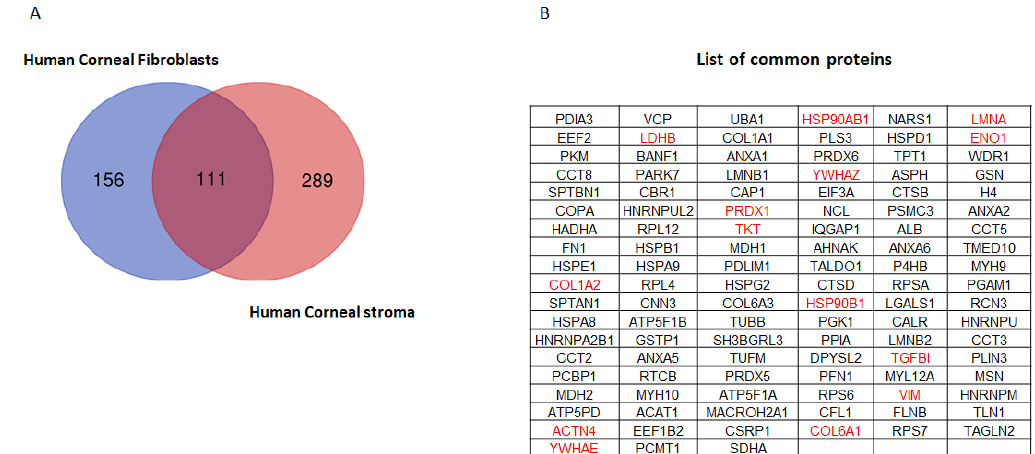
Figure 6. ( A ) Venn diagram of common and unique proteins compared between human corneal fibroblasts and human corneal stroma. A total of 111 proteins were found to be common between human corneal fibroblasts and human corneal stroma (cadaver). ( B ) List of common proteins between human corneal fibroblasts and human corneal stroma. The proteins highlighted in red are known to play a significant role in early wound healing process.